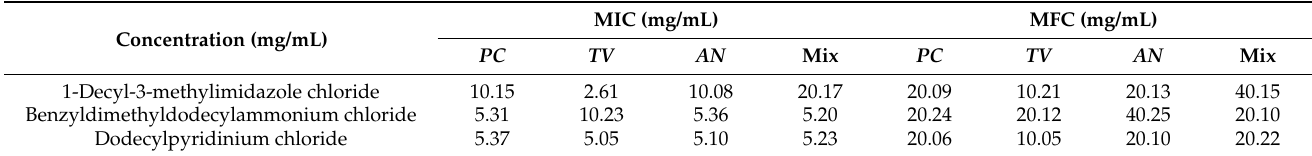
Table 1. MIC and MFC values of different types and concentrations of ionic liquids against bam- boo